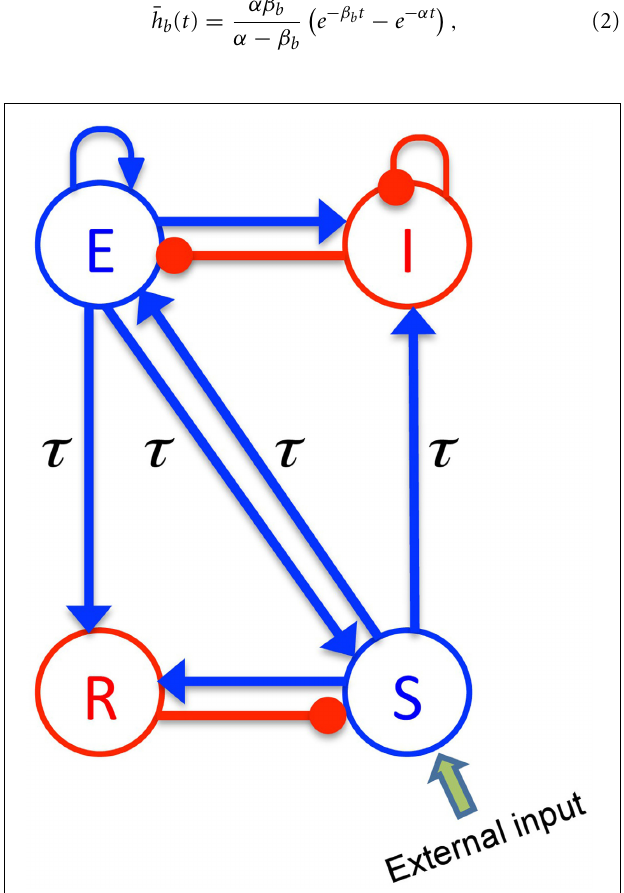
FIGURE 1 | The schematic of a thalamo-cortical module. The blue arrows indicate excitatory connections while the red connections with filled circle ends denote inhibitory connections. The symbols E , I , S , and R denote the excitatory and inhibitory cortical neurons, thalamo-cortical relay, and thalamic reticular neurons, respectively. In addition thalamocortical and corticothalamic connections exhibit the same nonzero time delay τ